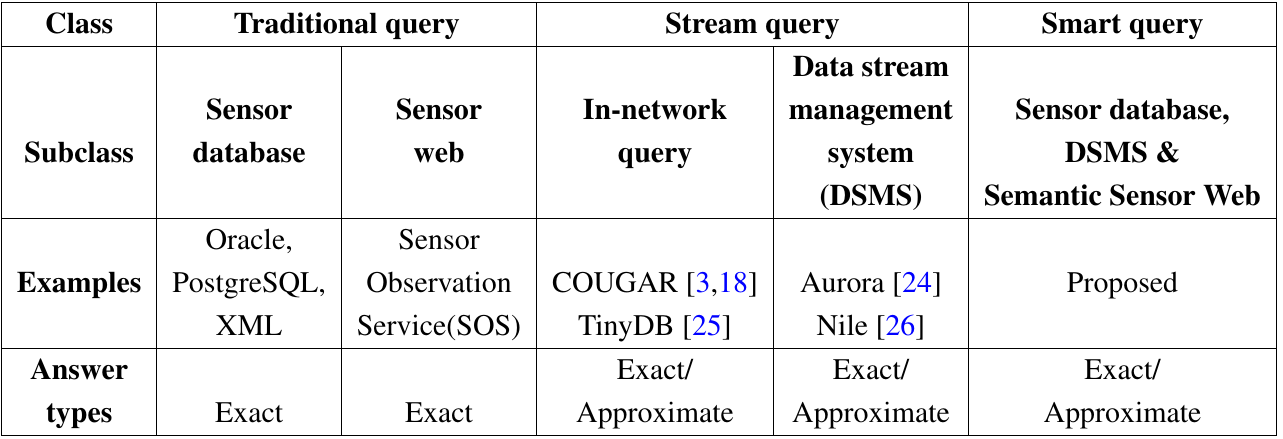
Table 1. Types of query processing based on answering techniques for sensor data.